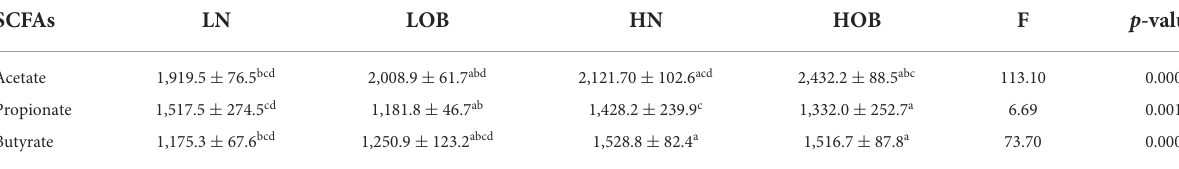
TABLE 5 Comparison of SCFAs in the four groups.